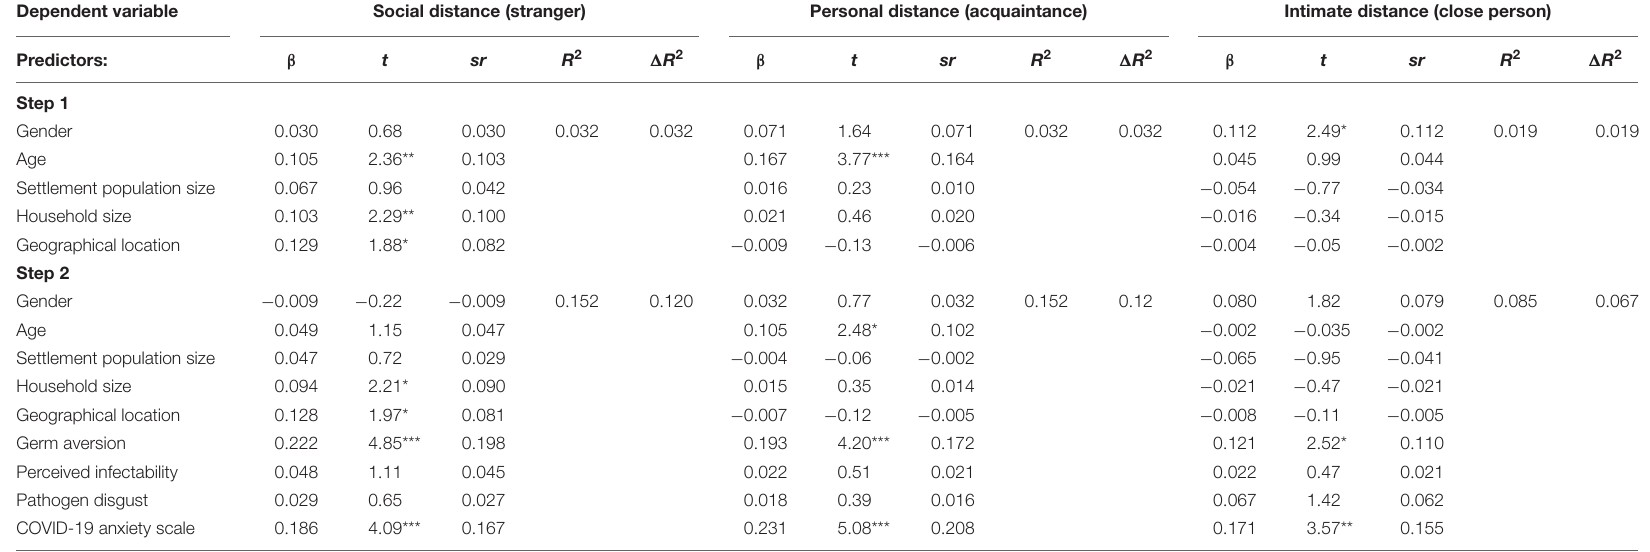
TABLE 3 | Summary of hierarchical regression analyses for variables predicting preferred interpersonal differences. Dependent